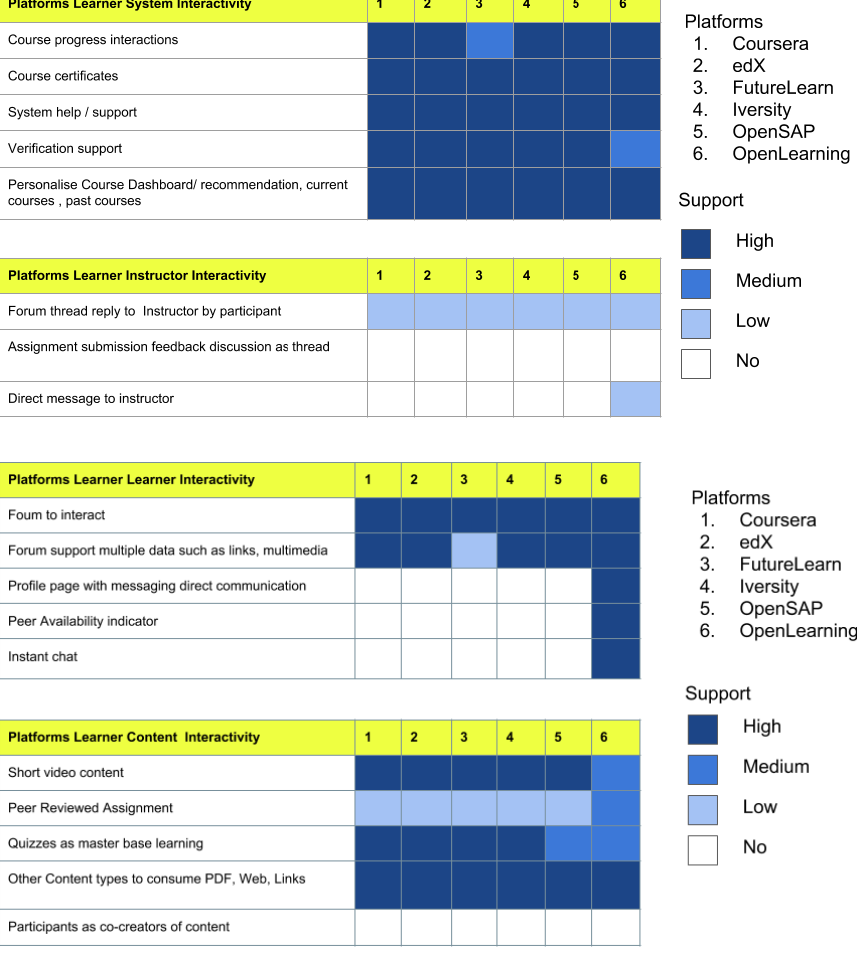
Fig. 2. Evaluation Matrix in Interactions ( L-L, L-C, L-S,